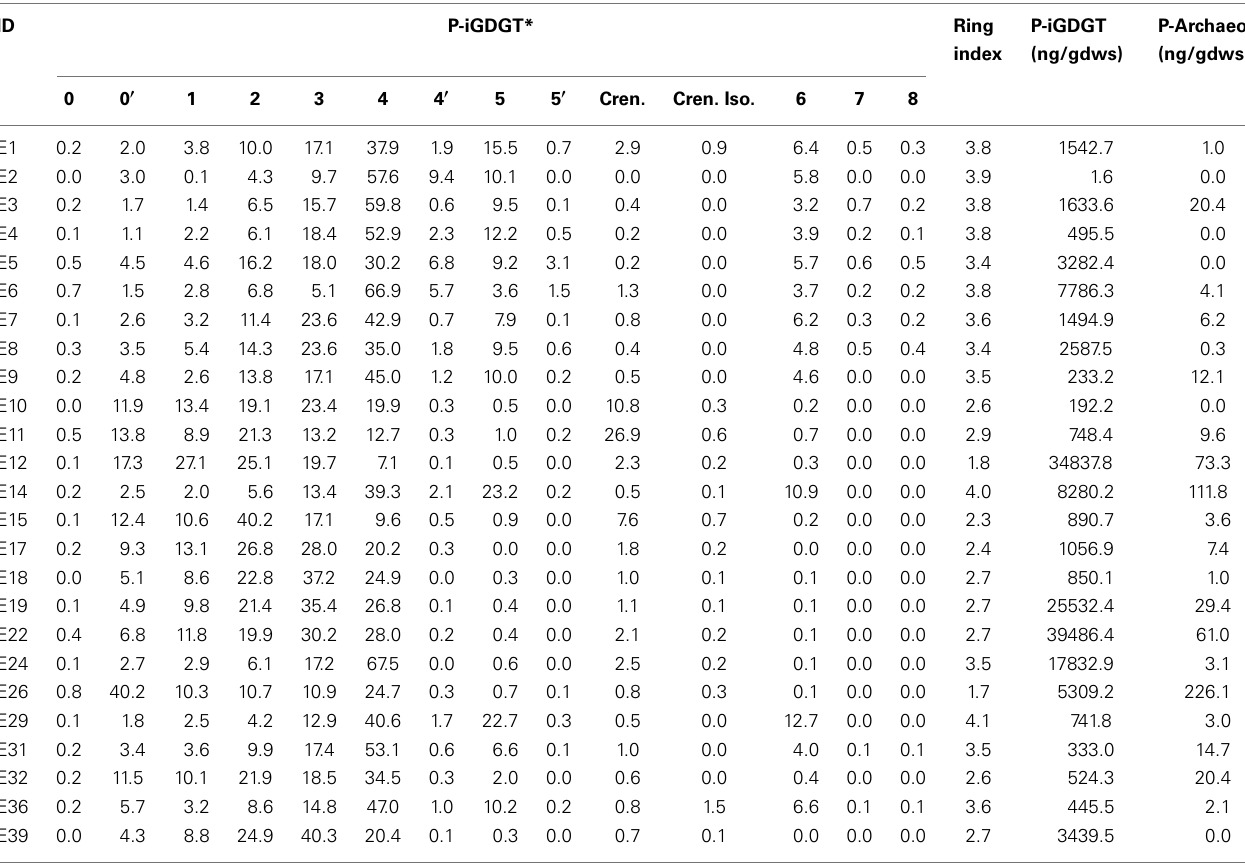
Table 3 | Relative abundance of P-iGDGTs in geothermal mat and sediment